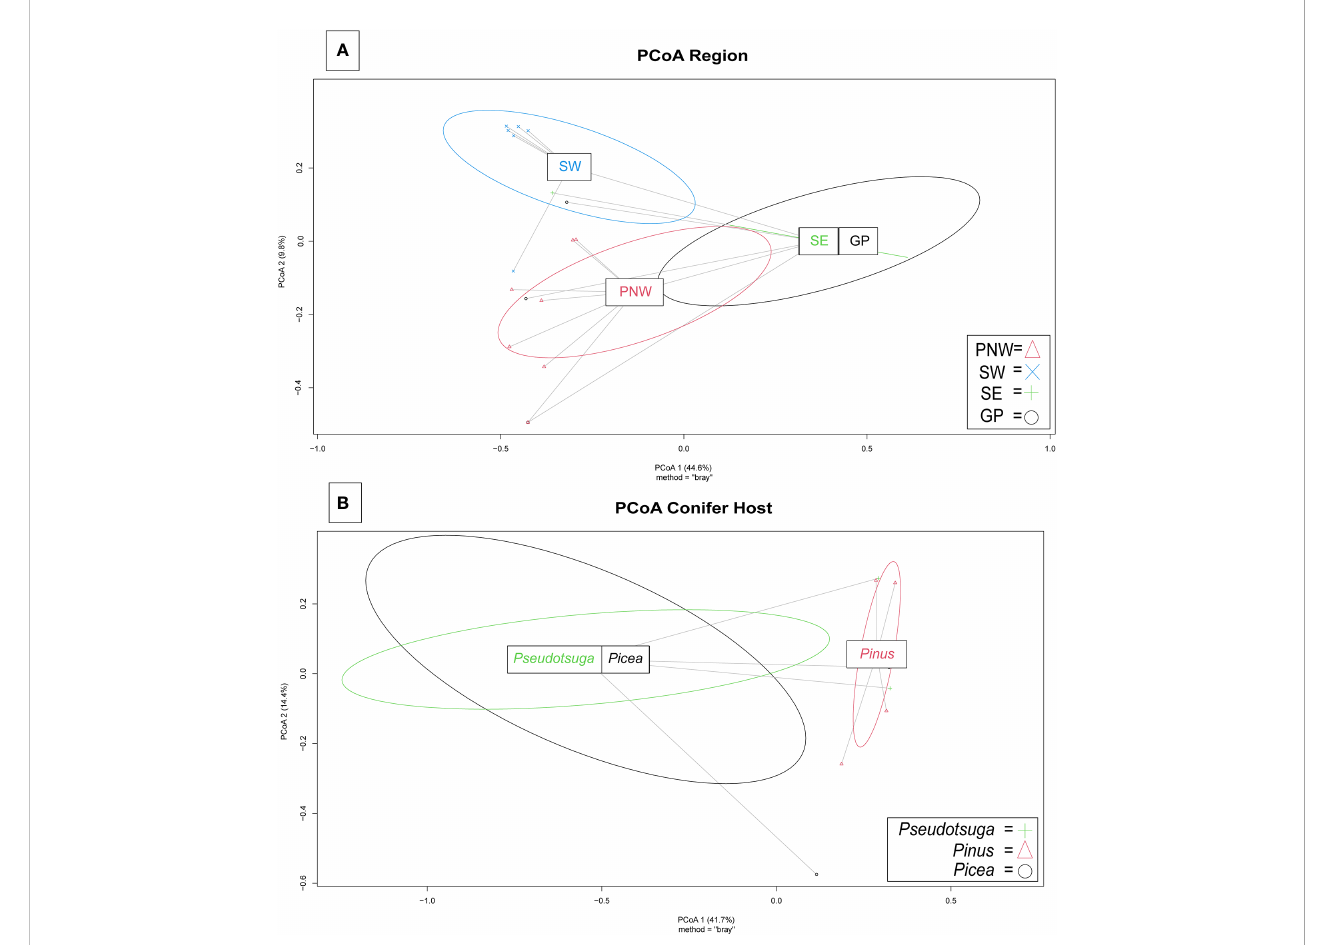
FIGURE 5 Principal coordinates analysis (PCoA) plots of Fusarioid fungi analyzed by the four regions [Paci fi c Northwest (PNW), Southwest (SW), Southeast (SE), and Great Plains (GP)] of the USA, where isolates were collected and the three most common host